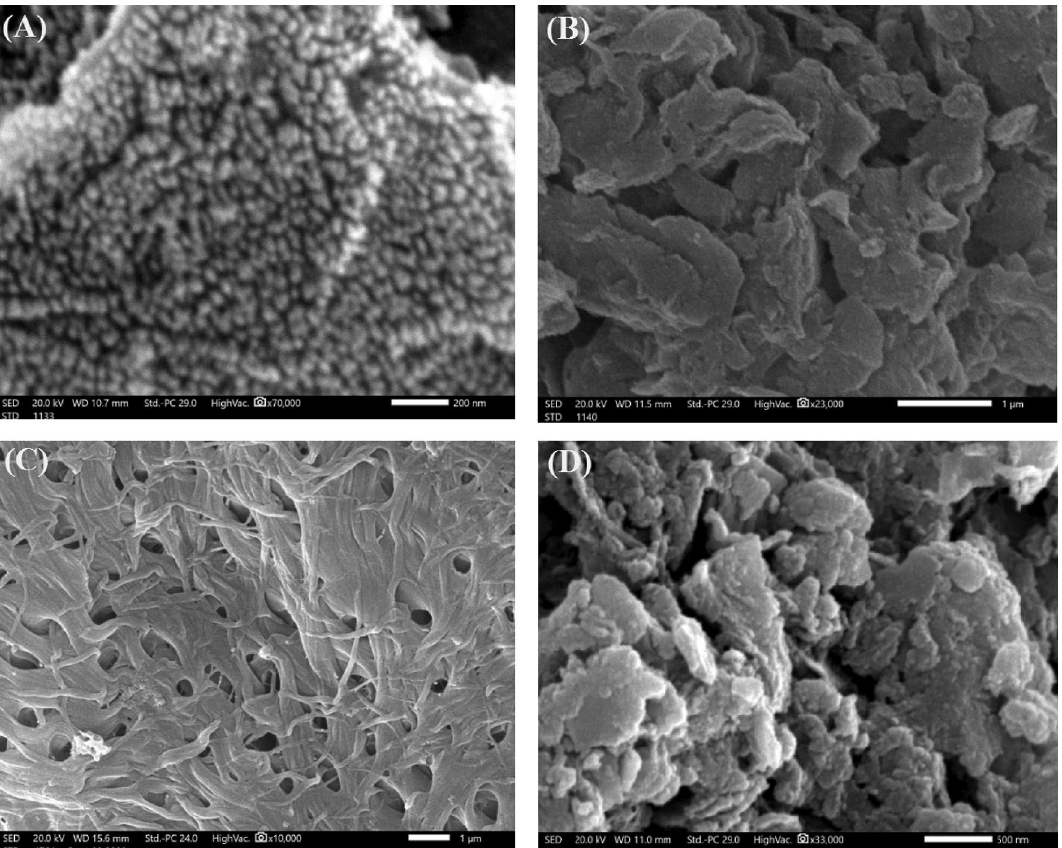
Figure 3. SEM images of ( A ) NiFe 2 O 4 , ( B ) MMT, ( C ) AmCs and ( D ) MMT-mAmCs